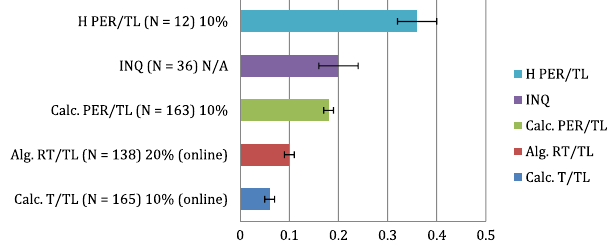
FIG. 7. Calculus and algebra-based CSEM normalized gain by laboratory and teaching style. The data are listed by laboratory or teaching style ( N ¼ number of students ) percentage total grade allotted to laboratories plus recitation . Lab styles are labeled by traditional (T), Real Time Physics (RT), combination RT and T (RT-T), developed at the University of Illinois (IL), and locally written PER-informed (PER). The lecture teaching styles are labeled by traditional lecture (TL), PER-informed lecture (PERL), and inquiry-based instruction (INQ). Honors sections are labeled with an H